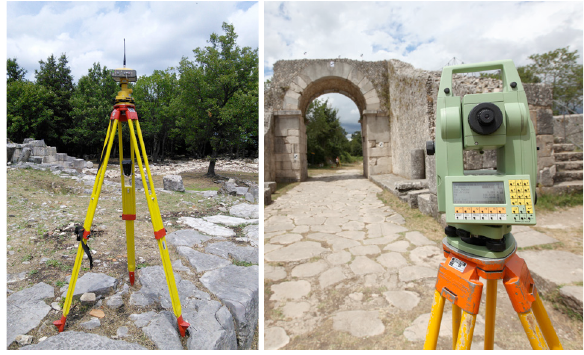
Figure 9. The topographic instruments